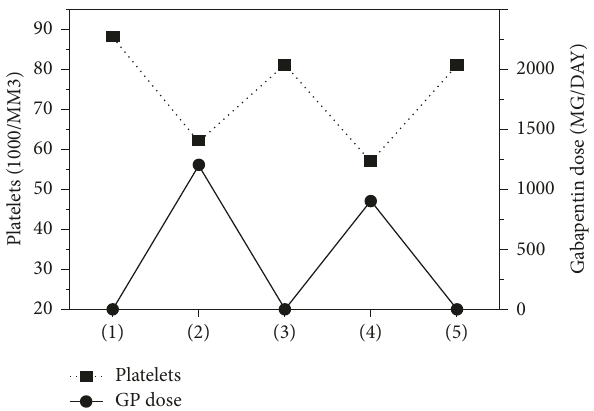
Figure 1: Platelet Levels and Gabapentin Doses . Data graphed over the same time course, specified as (1) initial value, (2) after first titration of gabapentin, (3) after gabapentin discontinued, (4) after second titration of gabapentin (restarted due to efficacy and consideration that thrombocytopenia might be secondary to HIV- induced thrombocytopenia rather than medication), and (5) after gabapentin discontinued